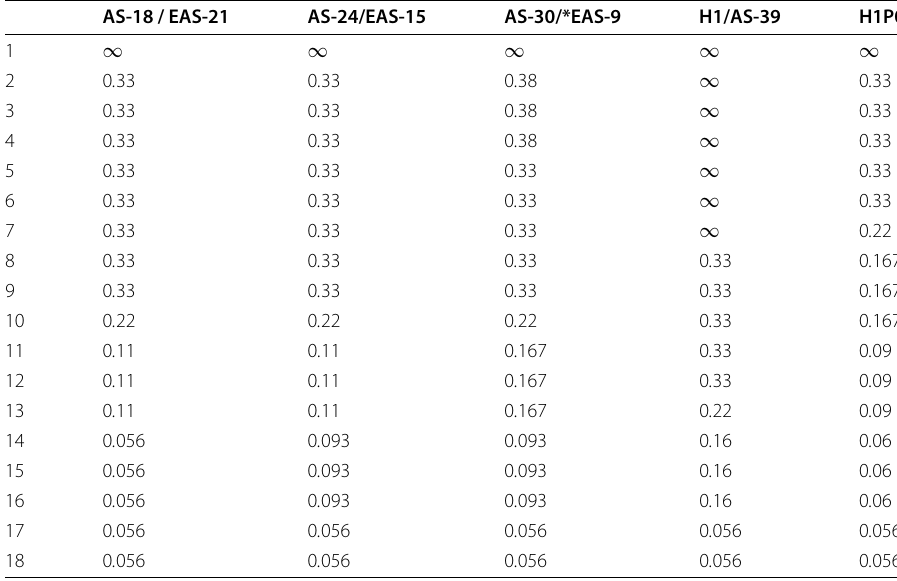
Table 5 Eigenvalue spectrum for incompressible square